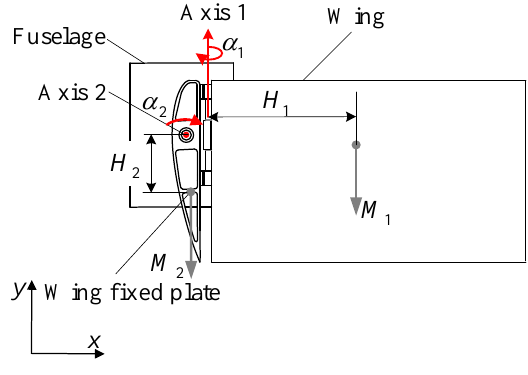
Figure 7. Simplified model of the folding wing.